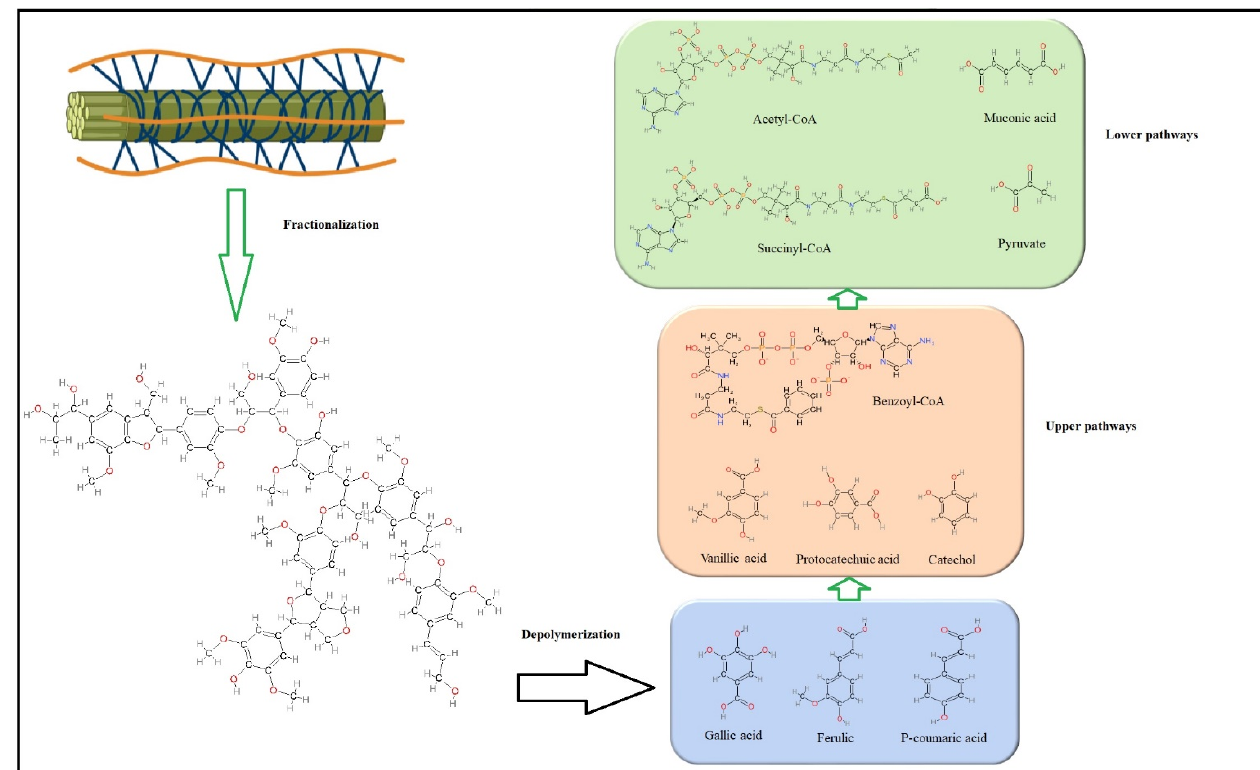
Figure 17. Depolymerization and pathways of